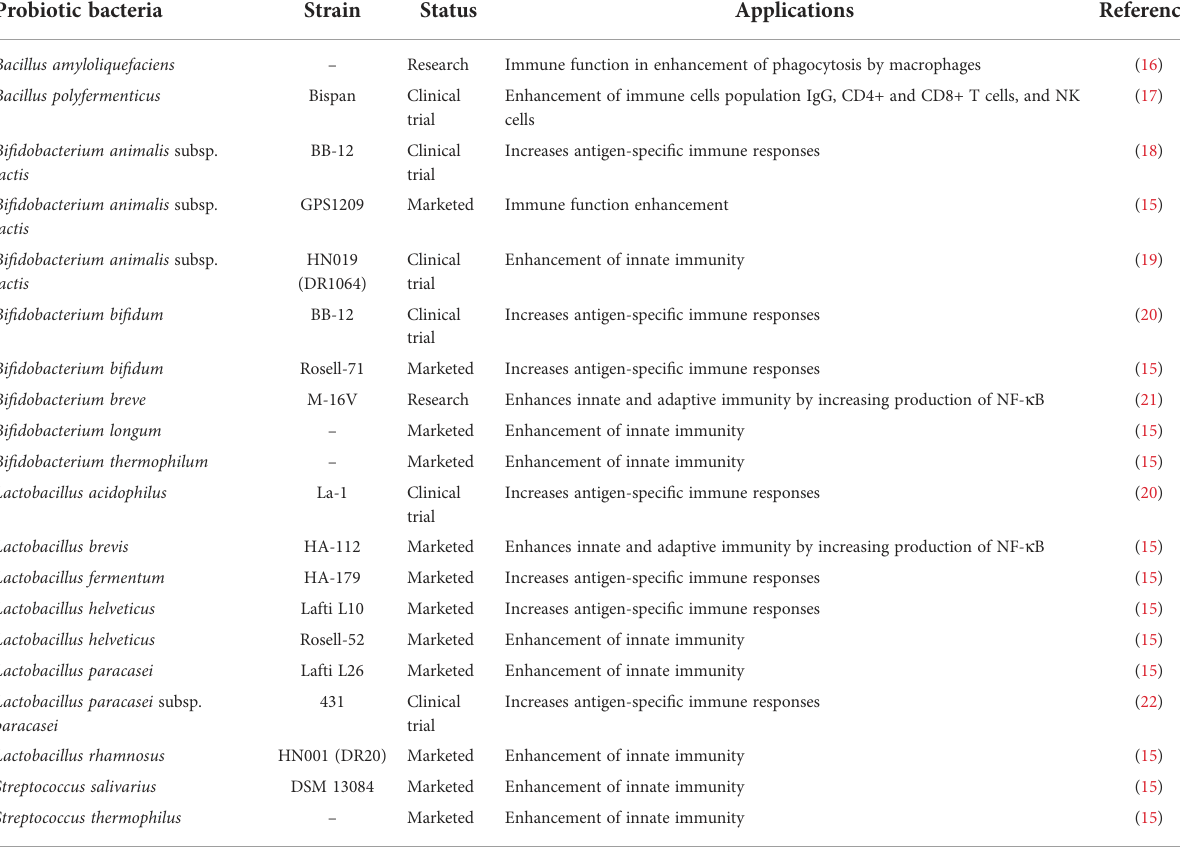
TABLE 1 Probiotic strains virtually screened from “ PROBIO ” database with potential immunomodulatory